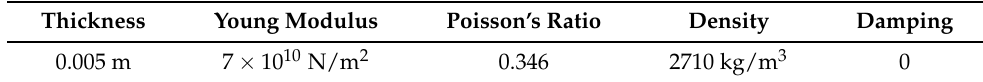
Figure 3. Geometry of the numerical model. Table 1. The property of